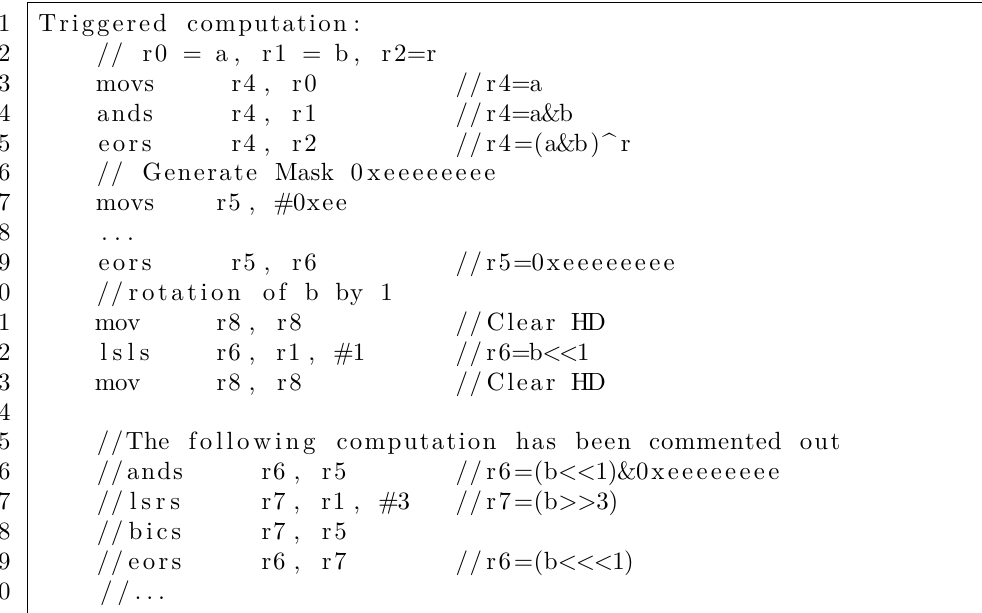
Figure 8: “Trimmed code” for 4-share Barthe et al.’s multiplication actually contains both shift left and shift right operations 5 : the unrolled version uses LSR (a.k.a right shift), whereas the rolled version uses LSL (a.k.a left